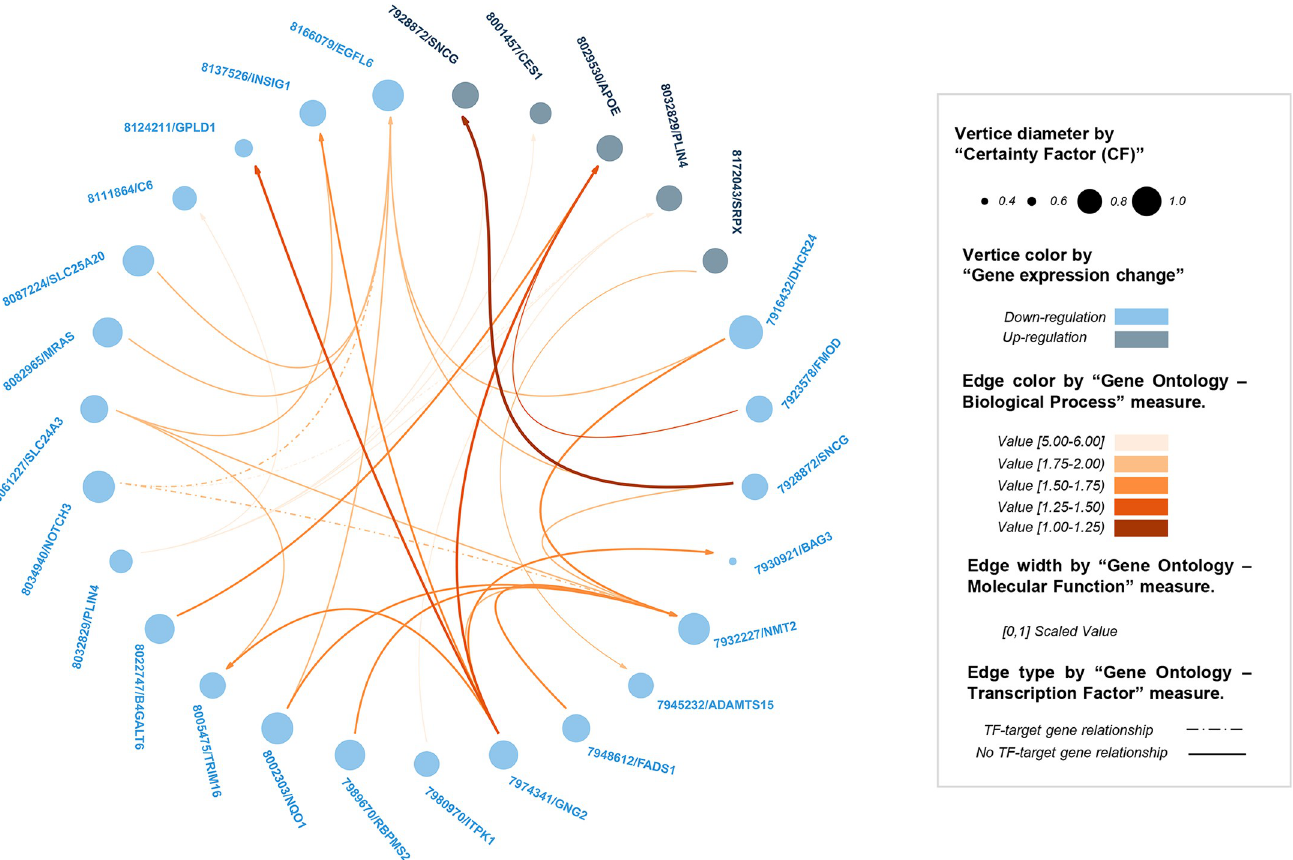
Fig 3. Visual representation of the sequential rules discovered by our method in the GSE77962 dataset (LCD group). Node names refer to (probe/gene).